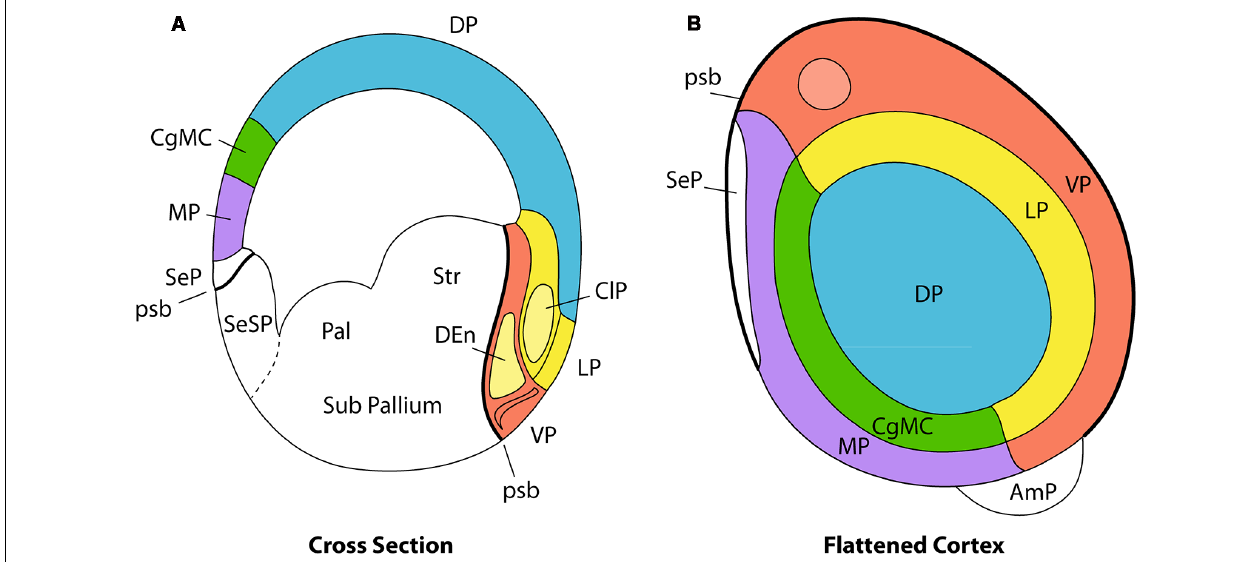
FIGURE 2 | Pallial organization in amniotes. Panel (A) is a schematic transverse section through the developing telencephalon. The pallium is divided into the medial pallium (MP; violet), dorsal pallium (DP; blue), lateral pallium (LP; yellow), and ventral pallium (VP; red). Cingulate mesocortex (CgMC; green) lies intercalated between MP and DP. The light-yellow structure inside the red VP area represents the DEn, a population that migrates from the claustral anlage in the LP, whereas the red superficial corticoid formation is the olfactory cortex. The principal claustrum (ClP) is the light-yellow oval-shaped area found within LP, while the overlying yellow part of the cortical plate represents the insular cortex. Panel (B) is a planar flattened view of the pallial telencephalon, using the same color codes for the pallial sectors. Note that the circulate mesocortex is represented as closing medially the half ring of the LP, whereas the MP closes the half ring of the VP. The white domain rostromedial to the MP represents the rostral septal pallium domain (SeP, seen in A below the MP and above the psb). The pallial amygdala (AmP) representing the topologic caudal hemispheric pole lies outside the MP/VP ring. Note that the distinguished pallial sectors show clearcut topological relationships, both dorso-ventrally ( A , cross section) and rostro-caudally ( B , flattened cortex; septo-amygdalar axis). These relationships are kept invariant throughout morphogenesis irrespective of any deformation suffered by the long axis of the telencephalon. Abbreviations: pallial/subpallial boundary (psb), pallidum (Pal), striatum (Str), amygdalar pole (AmP), olfactory bulb (olb; light-red), pallial septum (SeP), subpallial septum (SeSP). Adapted from Puelles